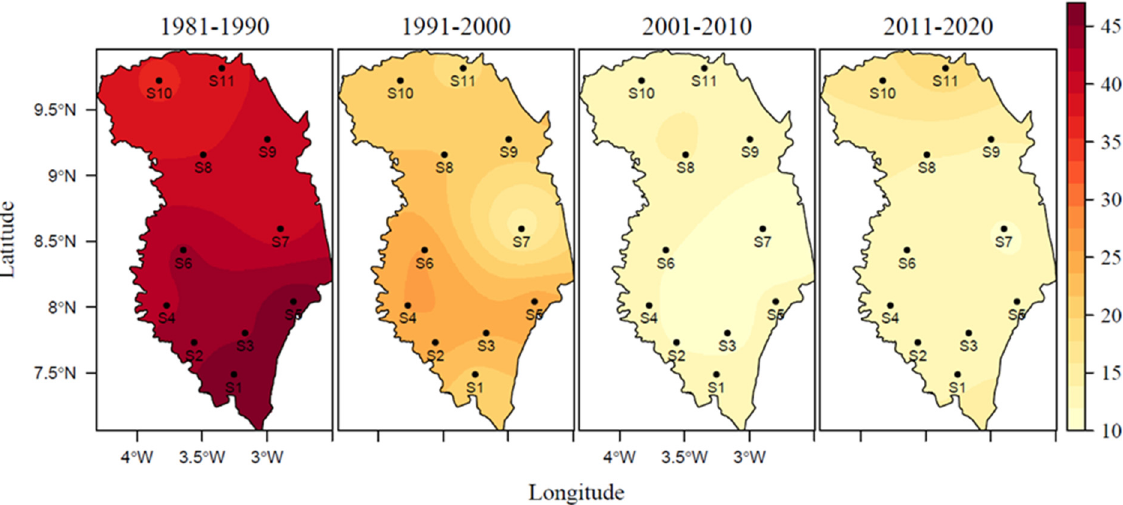
Figure 10. Spatial distribution of cold spell duration indicator (CSDI) (%) per decade in Zanzan region. Stations (S1 = Koun Fao, S2 = Kouassi-datékro, S3 = Tanda, S4 = Sandegué, S5 = Bondoukou, region. Stations (S1 = Koun Fao, S2 = Kouassi-dat é kro, S3 = Tanda, S4 = Sandegu é , S5 = Bondoukou, S6 = Nassian, S7 = Sapli, S8 = PN Comoé S1, S9 = Bouna, S10 = Téhini, S11 = Doropo). S6 = Nassian, S7 = Sapli, S8 = PN Como é S1, S9 = Bouna, S10 = T é hini, S11 =